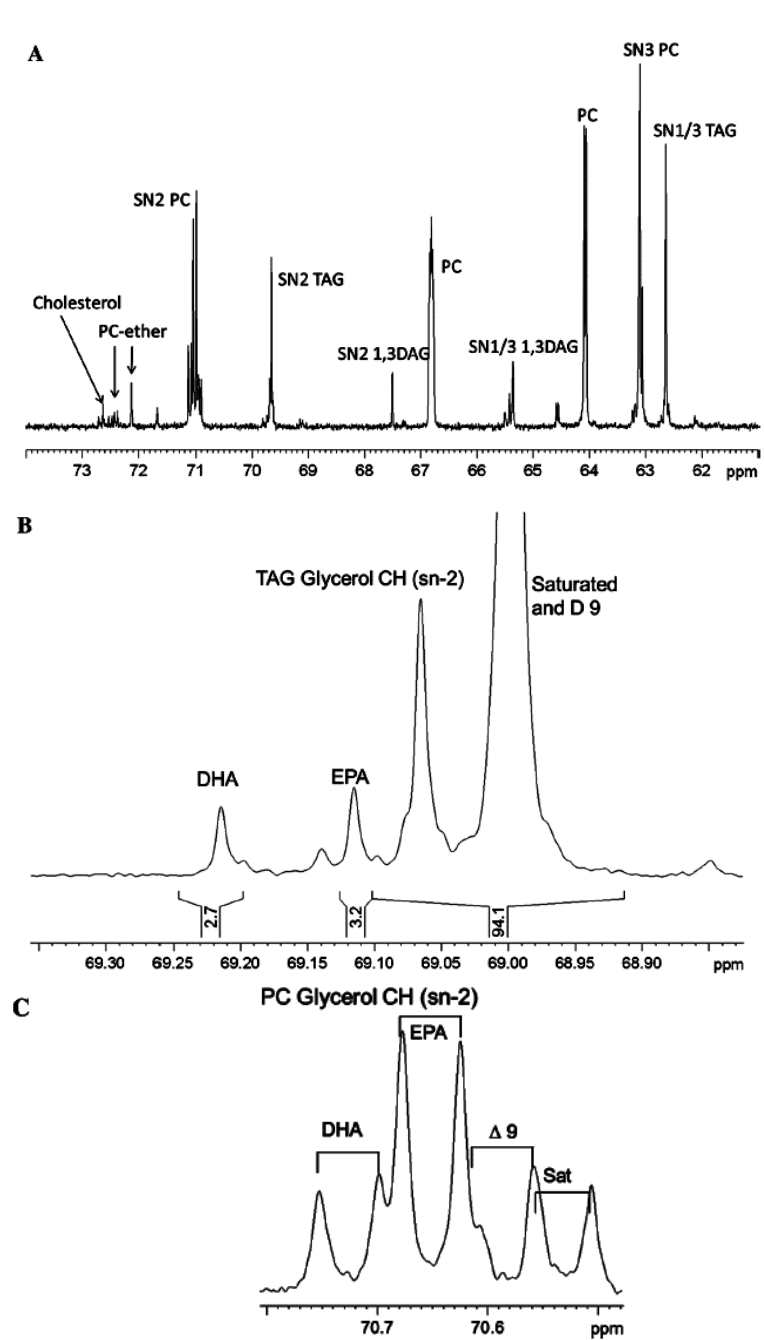
Figure 39. 13 C-NMR spectrum of krill oil in the region of glycerol carbon atoms ( A ). Selected 13 C regions of triacylglycerol (TAG) ( B ) and phosphatidylchorine (PC) ( C ). Adopted, with permission, from [197]. Copyright 2016,